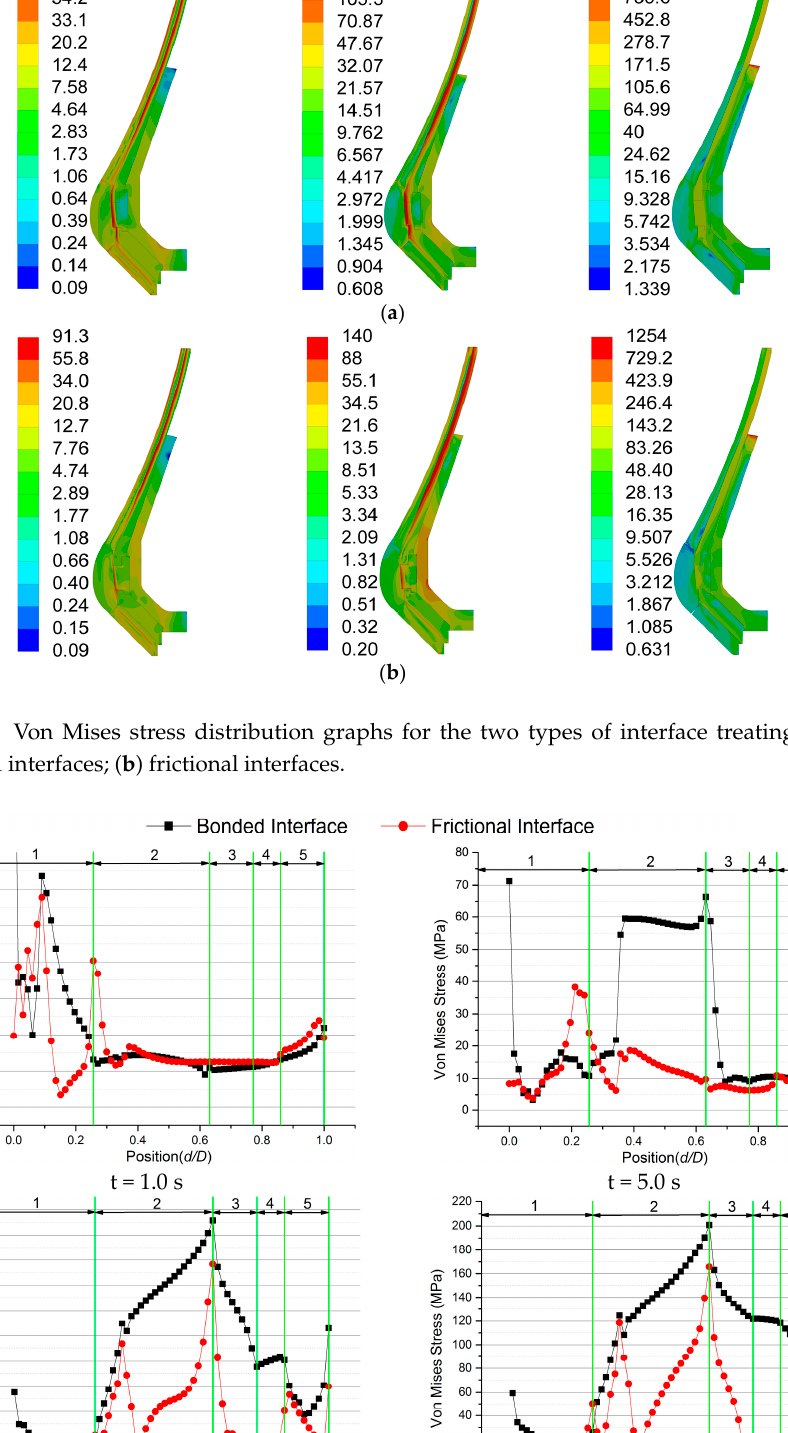
Figure 9. Temperature distribution curves of the passageway for the two types of interface treatment methods. 4.2.2. Stress Comparison Figure 10 shows the Von Mises stress distribution condition. The distribution character shows similar rules. There is also an apparent difference between the bonded and frictional results. The Von Mises stress level of the bonded interface is higher than that of the frictional one, especially at the interfaces around the nozzle insert and back surface. It can be inferred that the contact treatment is conductive to stress release. Figure 11 gives the Von Mises stress variation curves for the passageway. It can be easily found that frictional treatment can reduce the stress level at almost each point. At each time point, Von Mises stress of path 1 is basically at the same level. For path 2, the stress release effect of frictional treatment is the most efficient. For paths 3 to 5, the release effect is moderate. Figure 12 illustrates the axial stress variation curves of the passageway. As can be seen, there